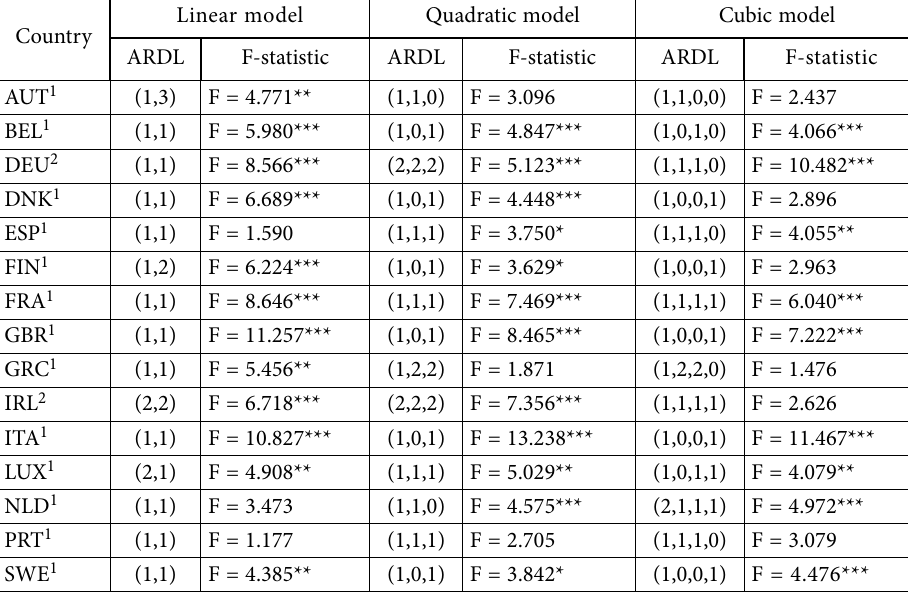
Table 1. Estimated ARDL models and bounds F-test for cointegration Linear Country